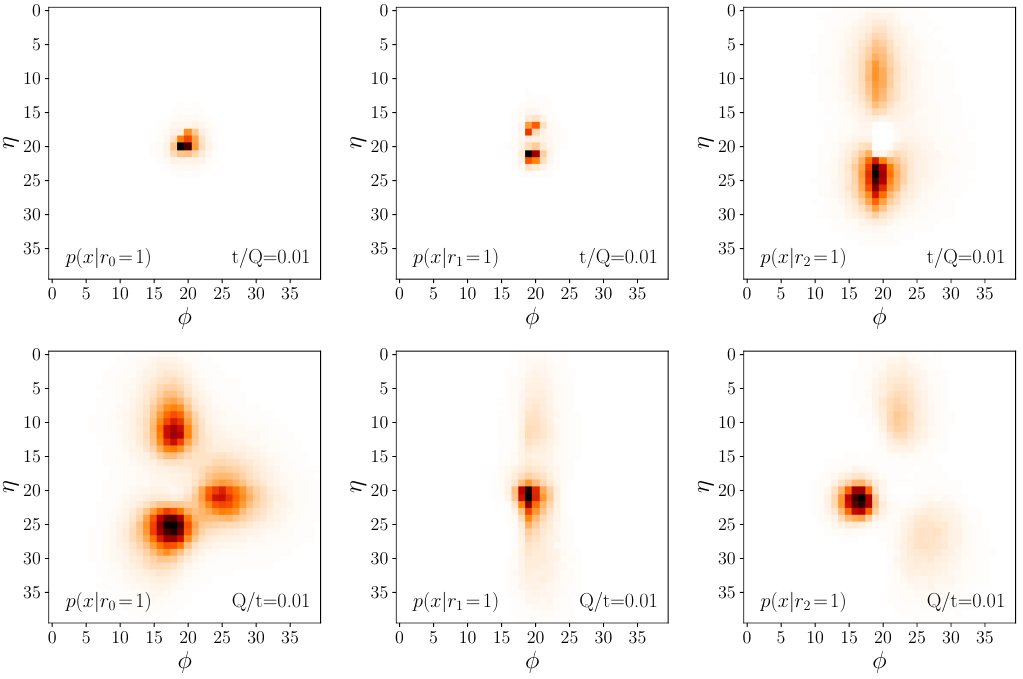
Figure 12: Three learned mixture distributions extracted from the decoder weights for t / Q = 0.01 (upper) and Q / t = 0.01 (lower). The mixtures are shown in order of their prevalence in the jet